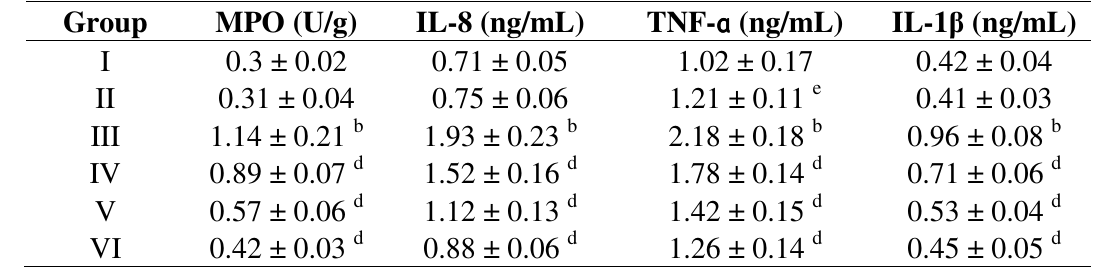
Table 2. Effect of GBE50 on myocardium MPO activity and blood IL-8, TNF- α , IL-1 β levels in